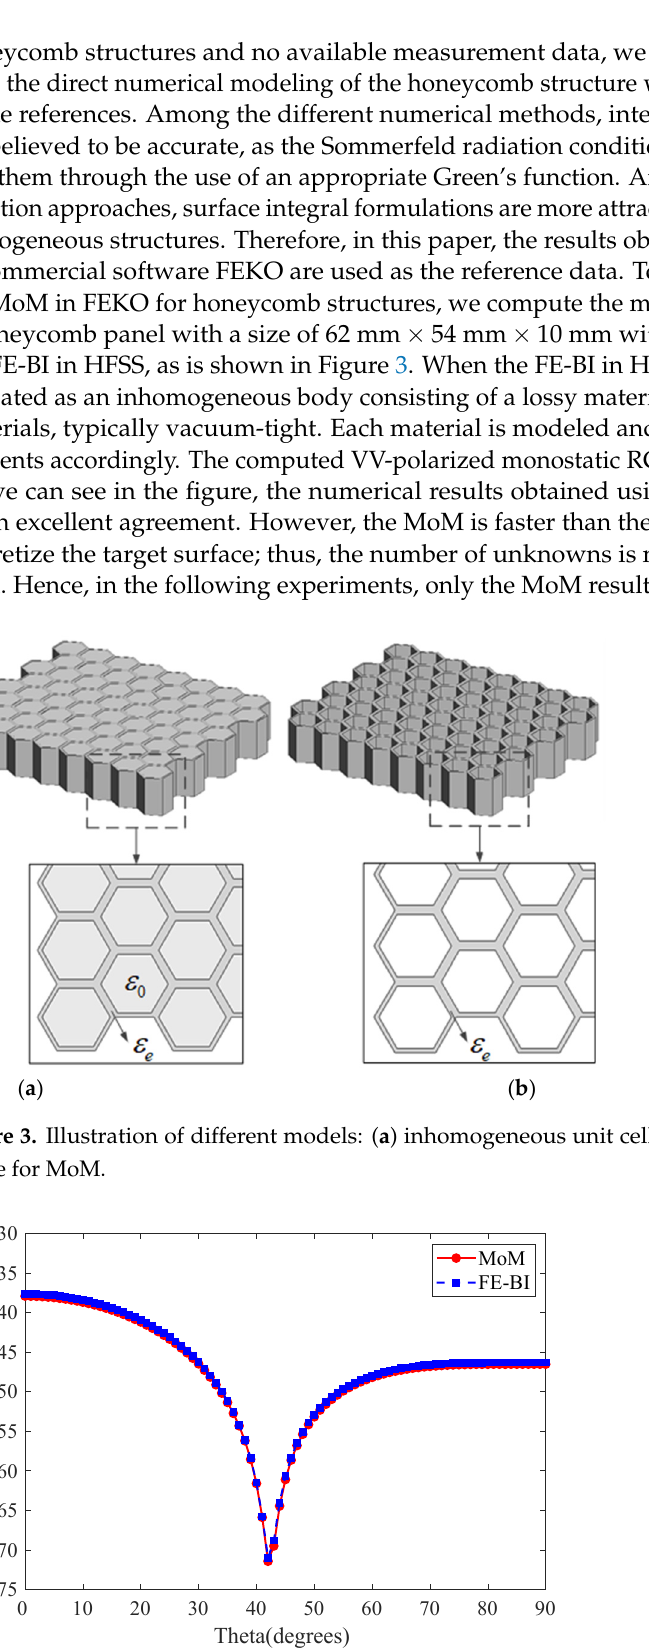
Figure 4. The monostatic RCS of a panel with size of 62